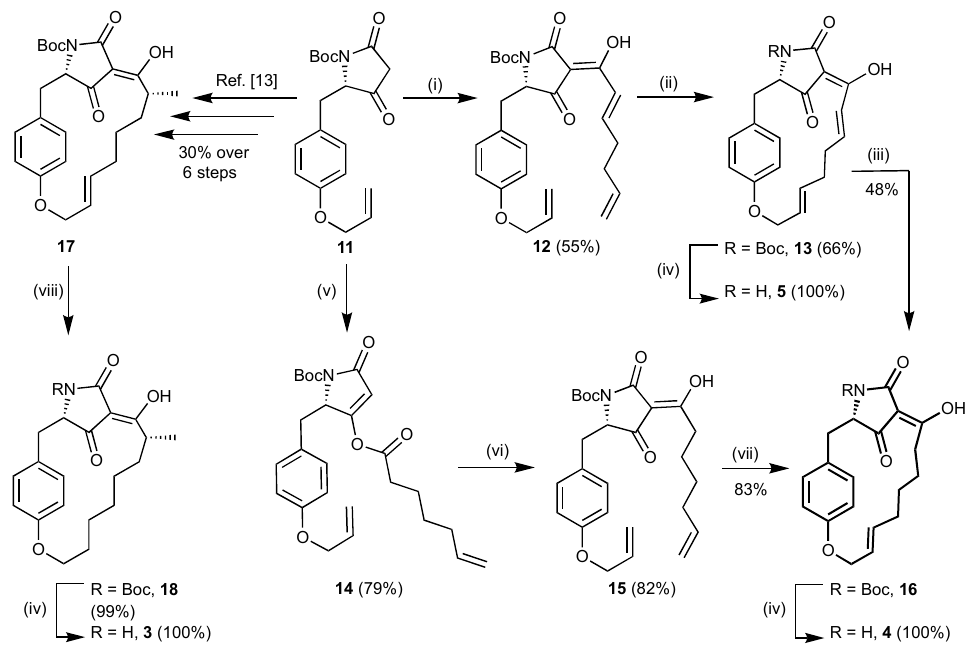
Scheme 1. Syntheses of key intermediate 16 and of macrocidin derivatives 3 , 4 , and 5 . Reagents